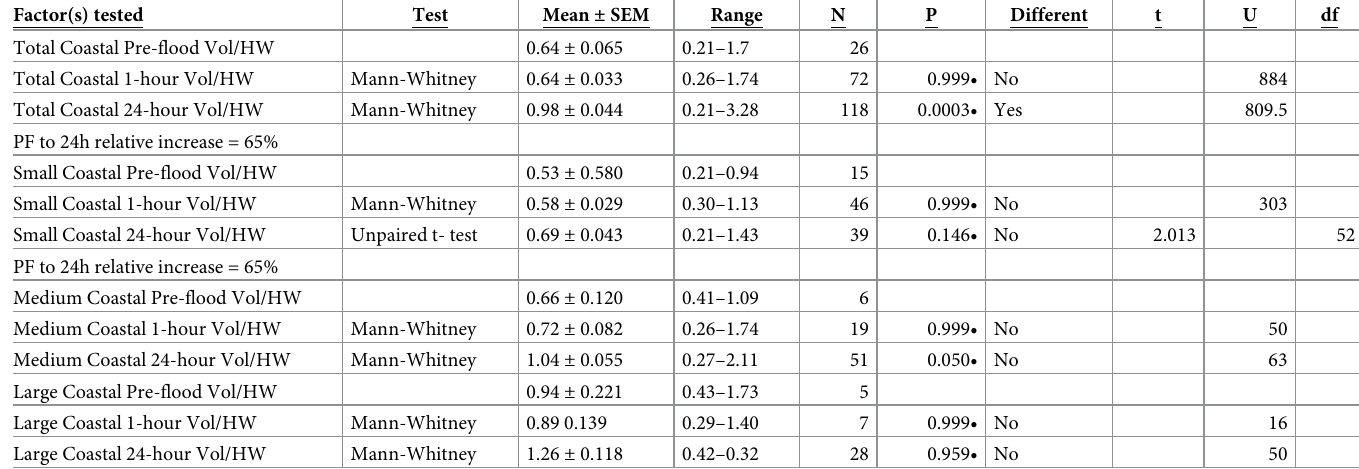
Table 2. Fire ant size venom sac volumes (calculated) corrected for body size via head width and results of statistical analysis for all coastal ants standardized for size. Bonferroni corrections were applied to the p-values used in multiple comparisons to reduce the possibility of a Type-1 error. Those p-values which were corrected are noted with a • symbol. Corrected p-values were compared to the Bonferroni-corrected α critical =